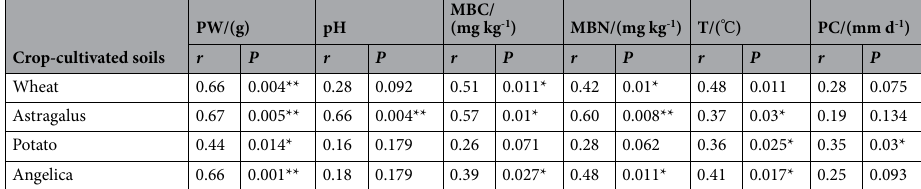
Table 2. Correlations between bacterial microbiota and ecological factors in crop-cultivated soils. Asterisk represented statistically significant differences between bacterial microbiota and ecological factors by Mantel test at P < 0.05 (*) and 0.01 (**). The meanings of PW, pH, MBC, MBN, T and PC were illustrated in Table 1. r , the correlation of two